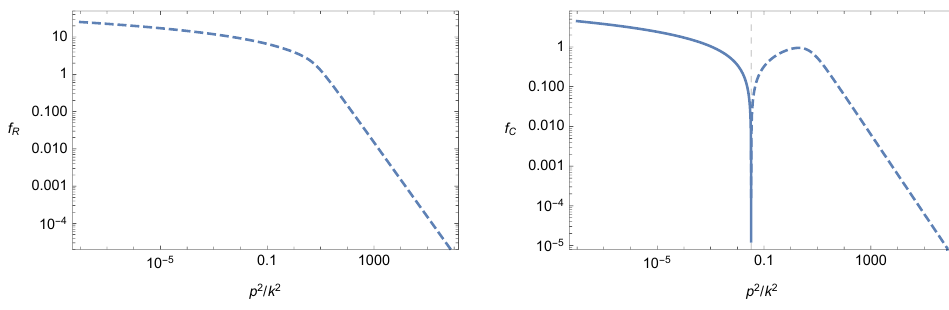
Figure 8. Background form factors f R and f C for the choices g = 1, Λ = 0, f R ( ∞ ) = 0, f C ( ∞ ) = 0 and the regulator (83). The dashing indicates that the function is negative in that regime. This choice of integration constants introduces additional poles in the propagator. For clarity, we have reinstated k in the momentum